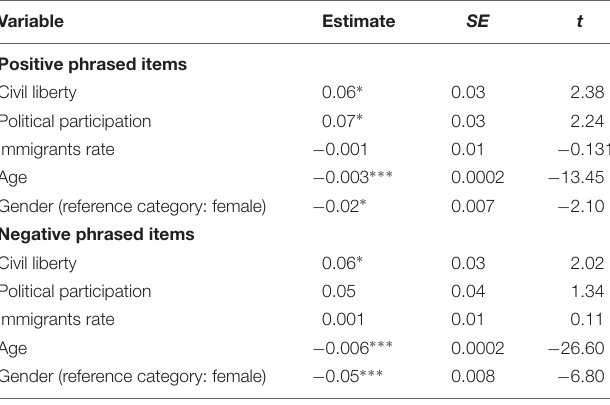
TABLE 1 | Fixed effect estimate for linear mixed model for positive and negative phrased items toward immigrants: Study